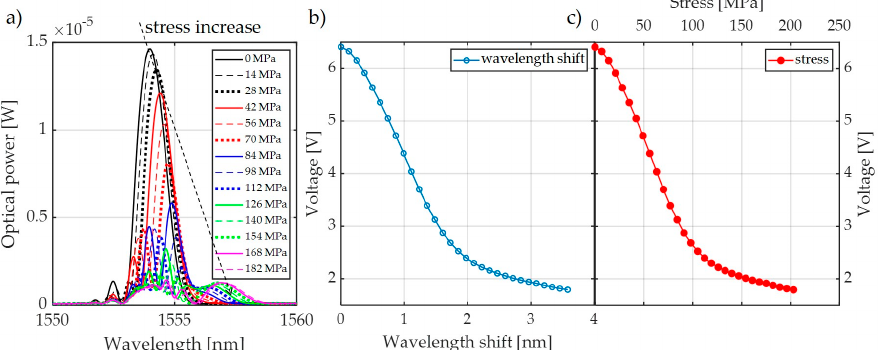
Figure 17. Measurement results using the interrogator presented in Figure 9 for the FBG + FBGF3 matched gratings pair: ( a ) change in the shape of the system output signal; ( b ) wavelength shift processing characteristics; ( c ) the characteristics of the power line conductor stress conversion to changes in the voltage on the photodetector.